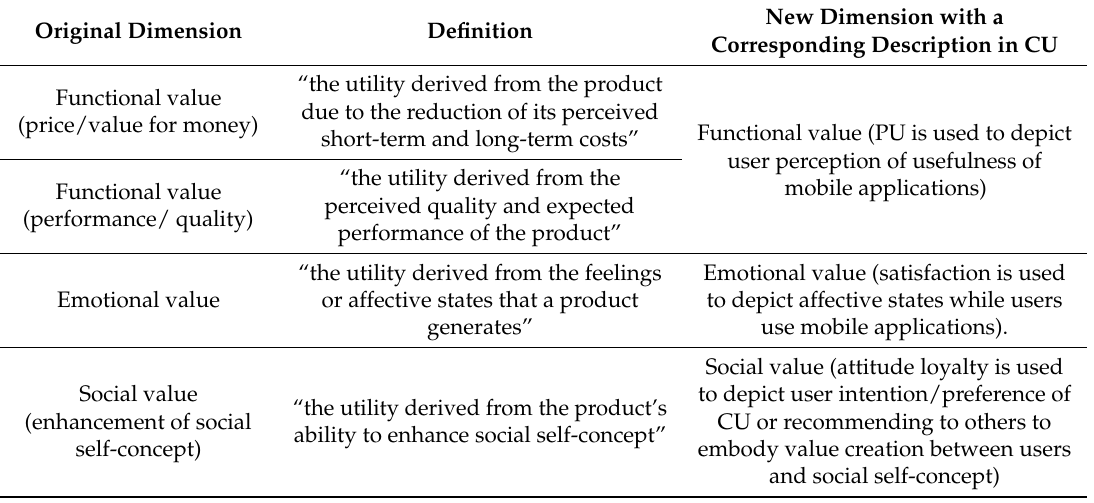
Table 1. Mobile terminal user value dimensions.